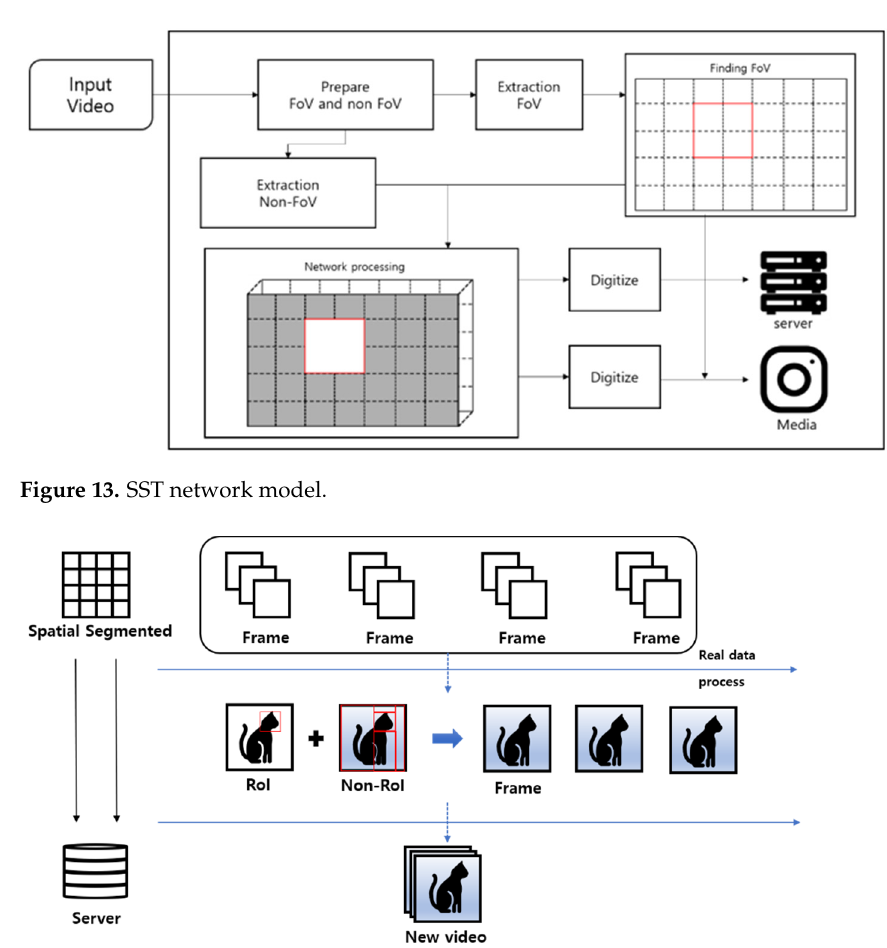
Figure 14. SST network processing.